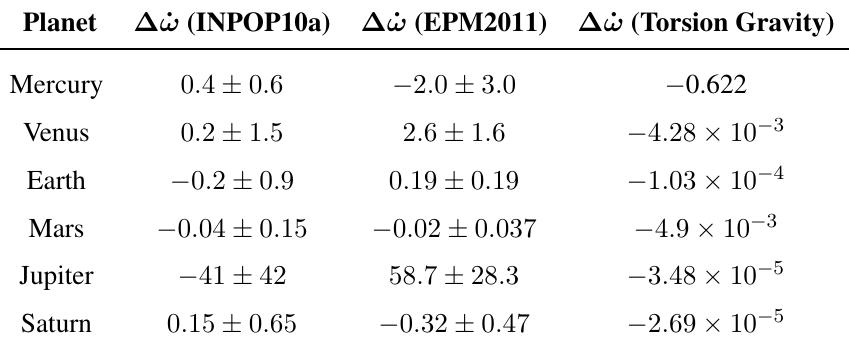
Table 2. Corrections to the secular perihelion precessions as obtained in the INPOP10a and EPM2011ephemerides and predictions of the torsion gravity model discussed in this paper in milliarcseconds per